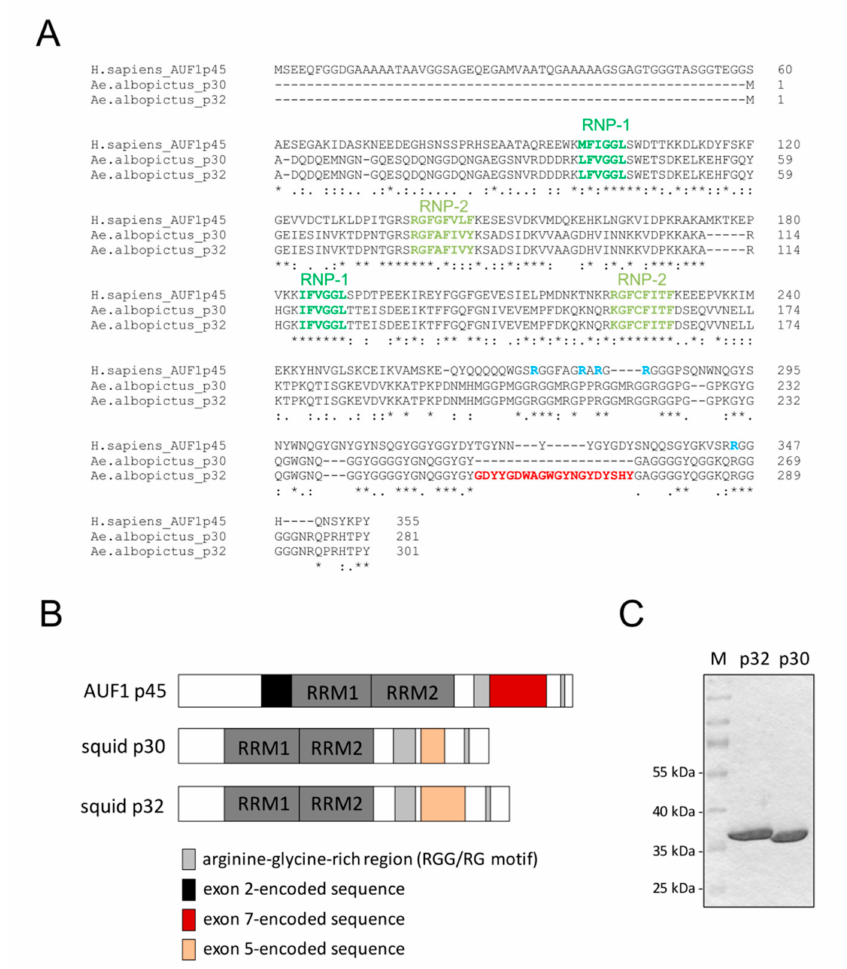
Figure 5. Mosquito cells encode two AUF1-homologous proteins. ( A ) Alignment of human AUF1 p45 and A. albopictus proteins p30 and p32. Conserved RNP-1 (light green) and RNP-2 (green) sequences of the RNA recognition motifs (RRM) are highlighted. The arginine residues of the RGG / RG motif of AUF1 p45 that were found to be dimethylated in human cells are highlighted in blue. The alternatively spliced sequence that is absent in p30 but present in p32 is shown in red. ( B ) Domain organization of human AUF1 p45 and mosquito squid proteins p30 and p32. ( C ) AUF1-homologous proteins p30 and p32 were produced in, and purified from, E. coli . About 4 µ g of protein were analyzed on a Coomassie-stained SDS-gel in parallel with a molecular weight marker